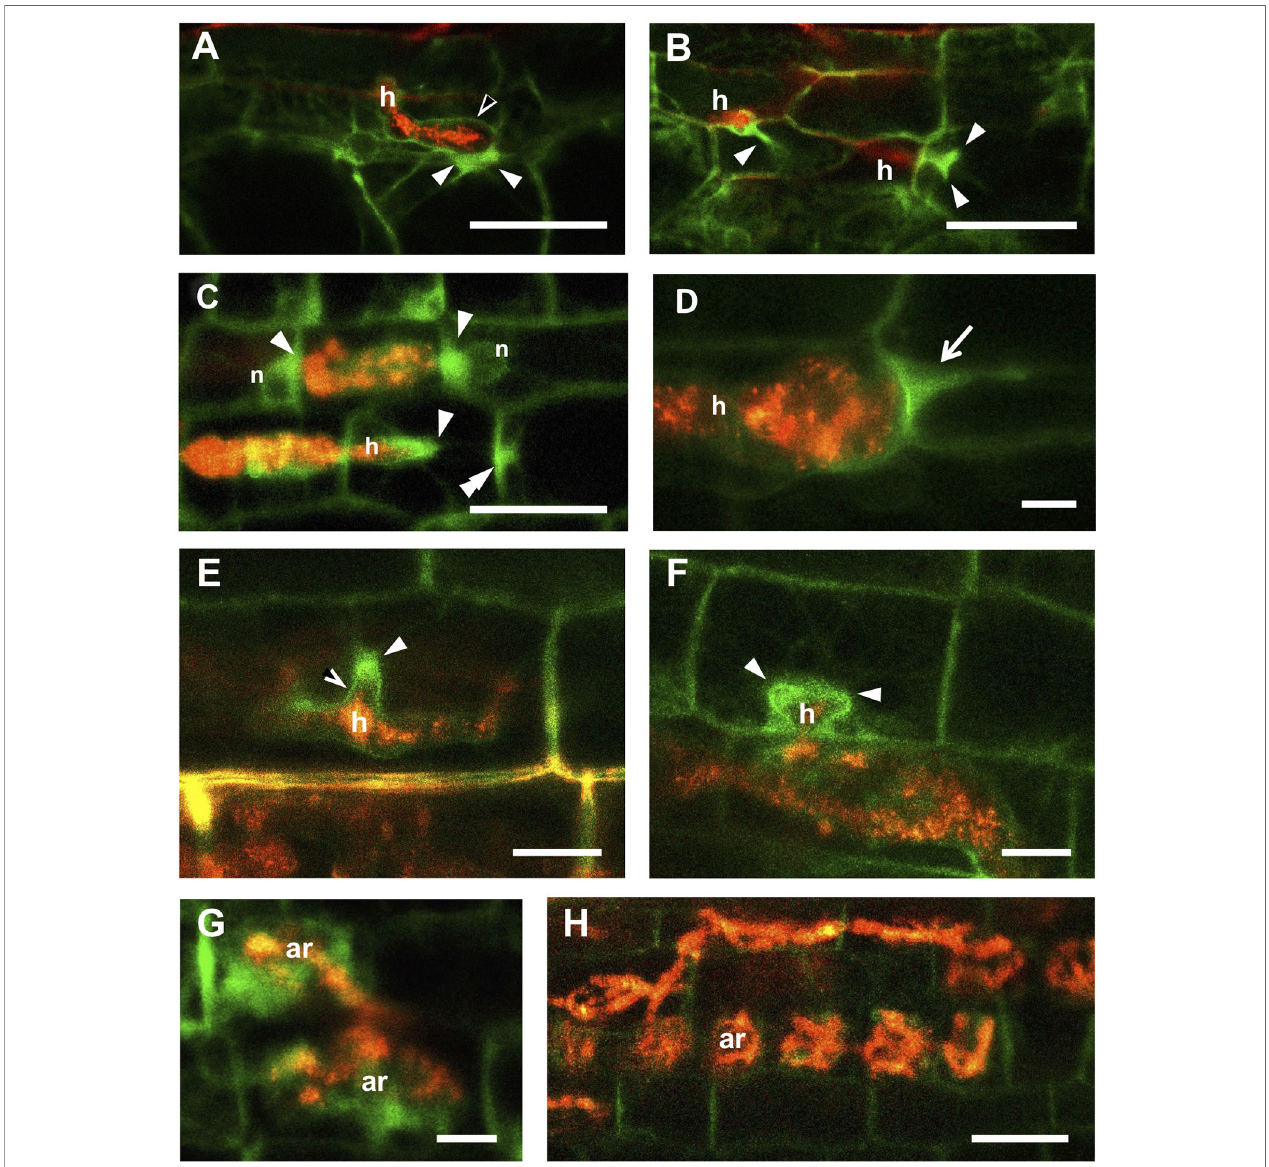
FIGURE 2 | TPLATE-GFP labeling of symbiotic interface in deeper layers of Medicago truncatula and Daucus carota roots. (A) shows an intracellular hypha (h) inside an M. truncatula root epidermal cell. The perifungal membrane appears outlined by a faint GFP signal (empty arrowhead), whereas intense fl uorescence accumulates in the developing PPA in the underlying outer cortical cell (arrowheads). An analogous situation is presented in (B) , where two hyphae (h) are imaged as they pass from cell to cell in the cortex: in both cases an intense fl uorescence marks the PPAs (arrowheads). PPAs labeling at different developmental stages are also observed in the cortex of D. carota (C – F) . Bright GFP signals are visible around the tips and branches of intracellular hyphae (arrowheads); along the cell wall at predicted hyphal exit site (double arrowhead in C ); and along the perifungal membrane behind the growing hyphal tip (empty arrowhead in E ). In (D) a Gigaspora gigantea hypha is on the point of passing from one cell to the next in the same fi le: the GFP signal marks the typical arrow-shaped PPA (arrow) of Paris -type mycorrhizas. (G) shows two young arbuscules (ar) surrounded by diffuse GFP fl uorescence, suggesting that TPLATE is also involved in arbuscule accommodation, while this intense signal is lost in cortical cells that harbor older arbuscules (H) . Bars = 50 µm in (A – C , H) ; 10 µm in (D – G)